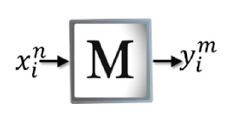
Figure 4. Recovery phase of the Am αβ .